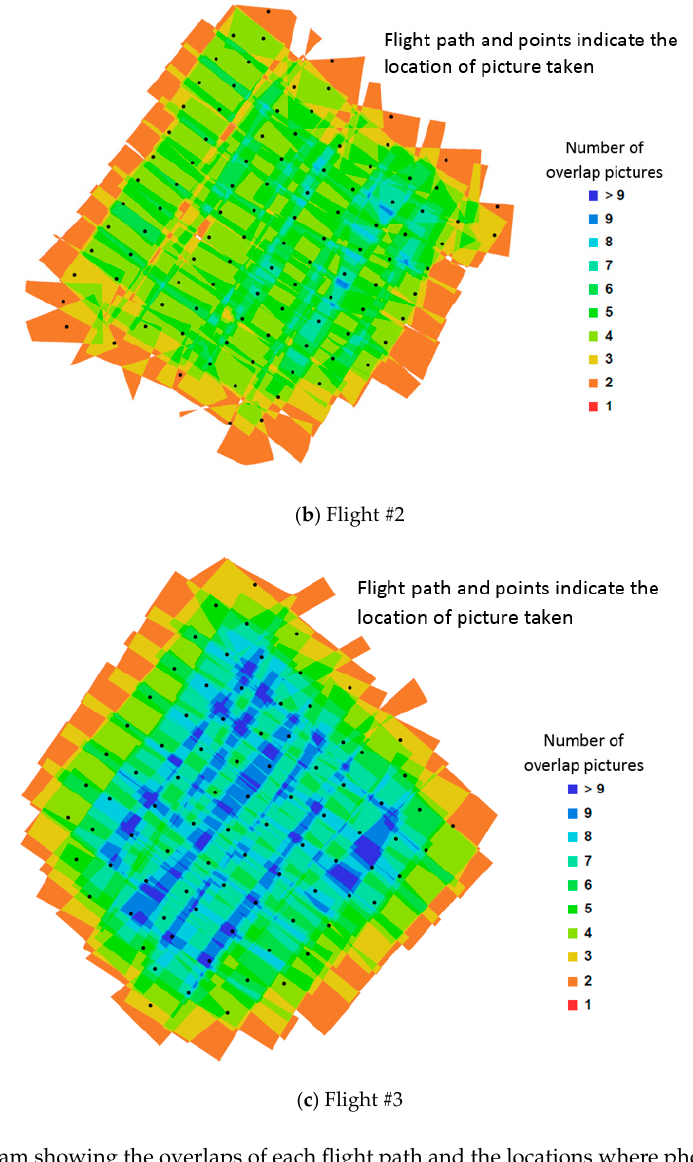
Figure 5. Diagram showing the overlaps of each flight path and the locations where photos were taken.